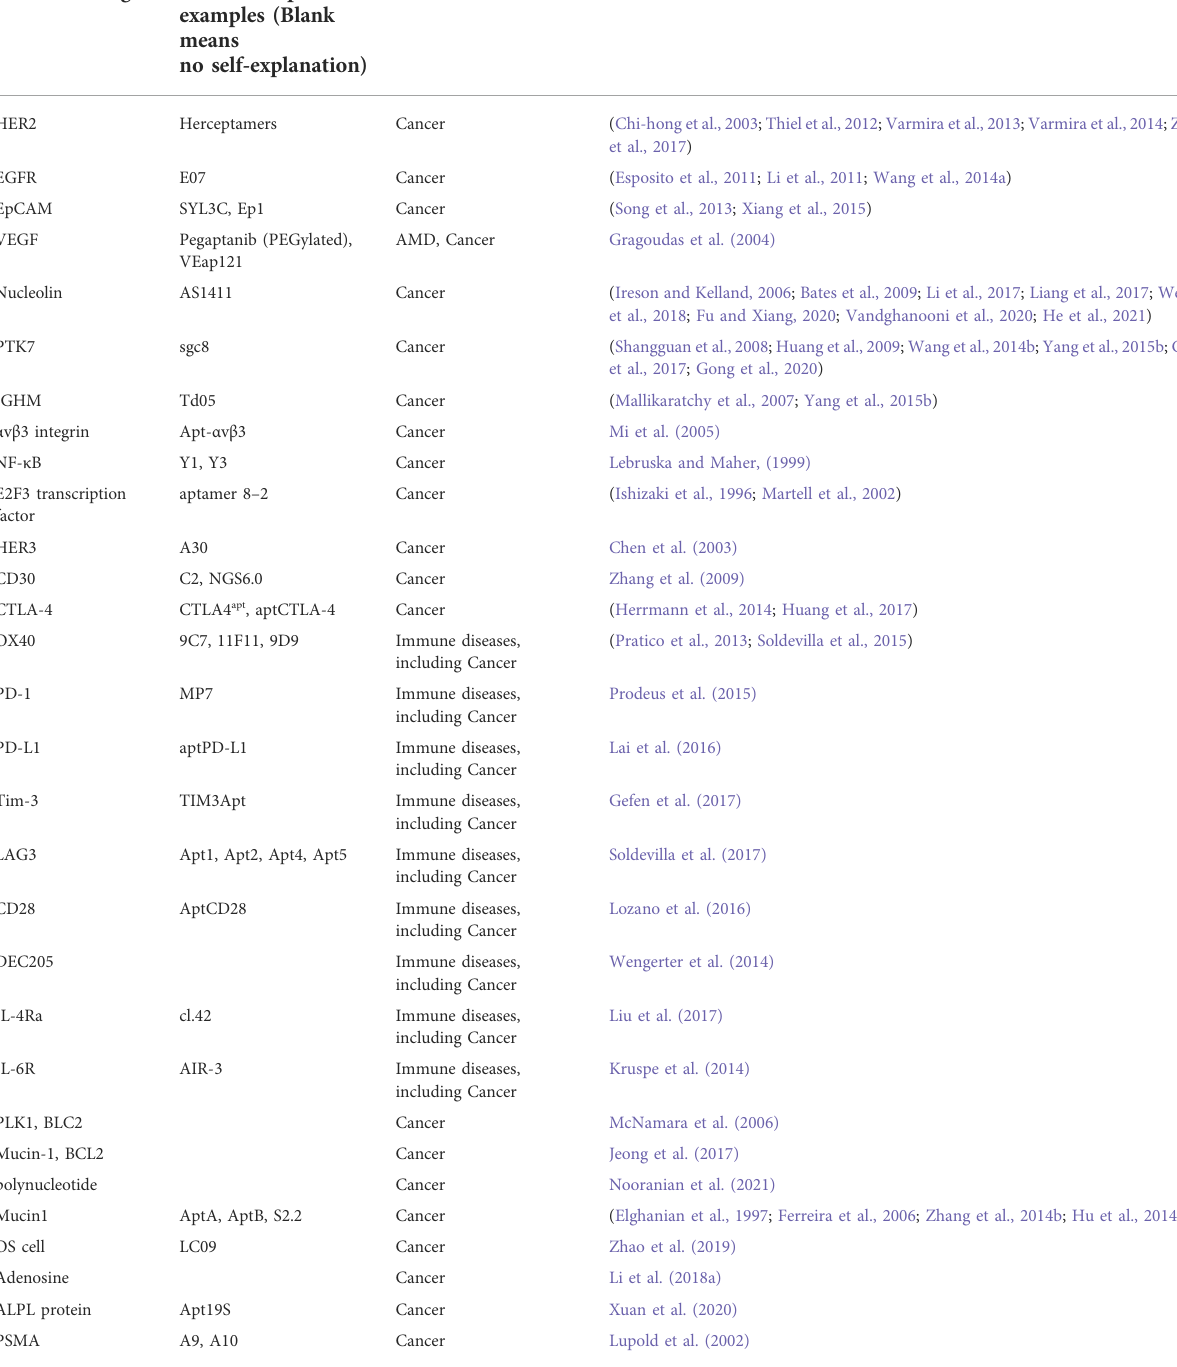
TABLE 1 Examples of therapeutic aptamers in clinical stages for cancer